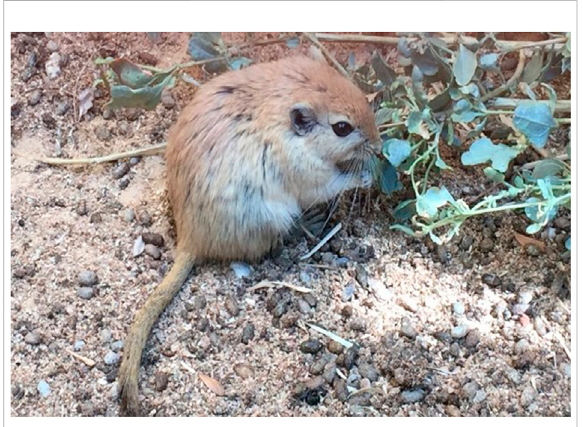
FIGURE 1 The fat sand rat ( Psammomys obesus ) feeding on its favorite diet, saltbush ( Atriplex halimus